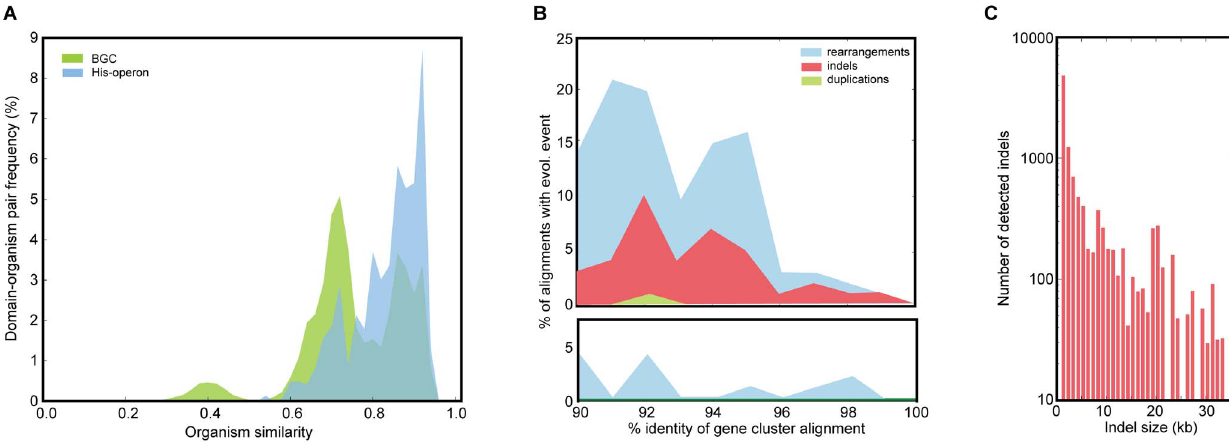
Figure 1. The rapid and dynamic evolution of BGCs differs from the evolution of ribosomal gene clusters and primary metabolism. a , Distributions of the best matching sequence homologs with respect to organism similarity (based on 16S rRNA) for predicted BGCs and histidine operons suggest significant differences in the ways they evolve. b , Number of detected rearrangements, indels and duplications plotted against the average percent identity in the aligned gene cluster pairs from which the events were deduced for predicted BGCs (top) and ribosomal gene clusters (bottom). Ribosomal gene clusters were selected for comparison based on their relatively large sizes ( , 10–15 kb) compared to primary metabolic operons; to obtain a fair comparison with BGCs, only gene clusters of sizes 5–15 kb were taken into account. Counts are based on a systematic comparison of all gene clusters in our data set that share regions of . 1000 bp with . 70% identity, in which events were inferred from alignments of such 1000 bp blocks. Of the 10,096 BGC pairs meeting these criteria, 1,750 had a rearrangement, 1,140 had an indel, and 135 had a duplication, each of which were far more common than the corresponding evolutionary events in gene clusters encoding the translation apparatus. Interestingly, while indels and rearrangements could be detected in , 16% and , 19% of BGCs of all sizes, duplications are found far more commonly in gene clusters with sizes of . 40 kb (7.6%) than in gene clusters with sizes of 10–20 kb (0.3%), suggesting a possible role for duplication and divergence in the evolution of large gene clusters. c , Size distribution of inserted/deleted fragments during recent gene cluster evolution, based on the indel analysis.